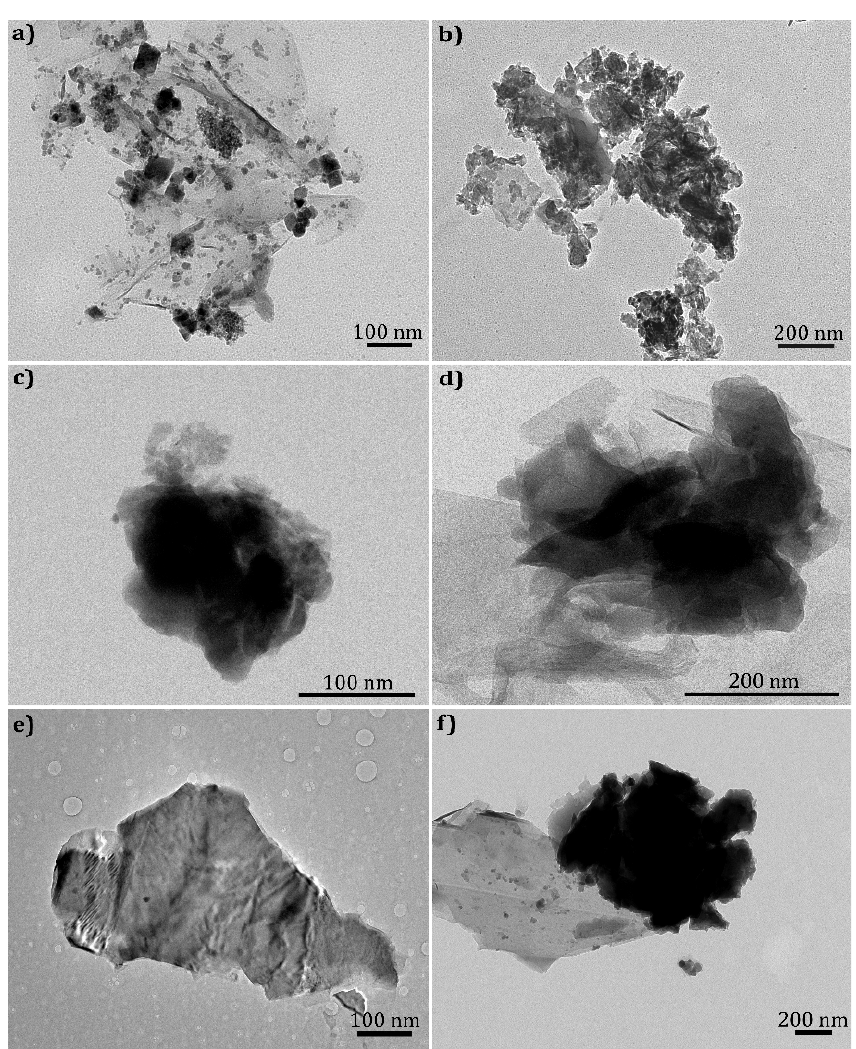
Figure 2. TEM micrographs of as-received GnPC, GnPM, and GnPH ( a , c , e ) and f GnPC-PP, f GnPM-PP, and f GnPH-PP ( b , d , f ).